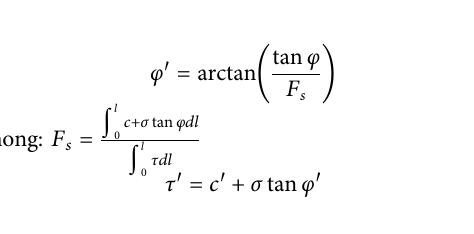
FIGURE 13 | Rock-slag and sand slope model calculate results: (A) vertical displacement diagram of rock-slag and sand soil without support; (B) horizontal displacement diagram of whole-rock slag; (C) XZ plane strain diagram of whole-rock slag; (D) plastic strain diagram of whole stone slag.